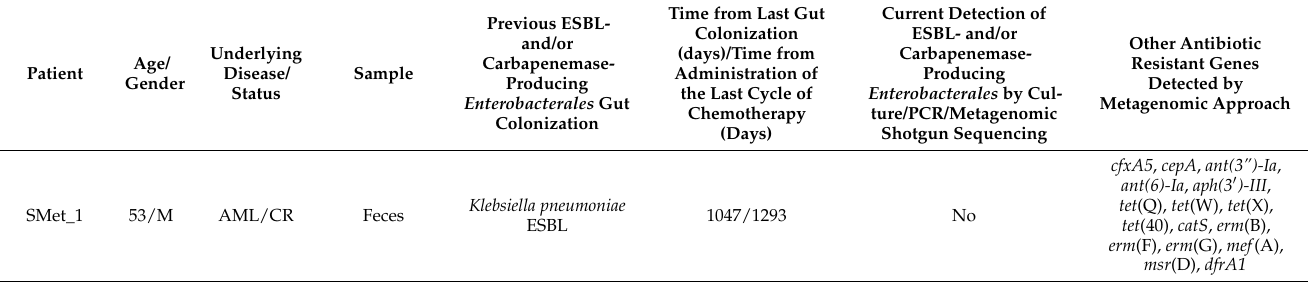
Table 1. Clinical and microbiological information of outpatients recovered from acute leukemia or that underwent stem cell transplantation and who had been colonized by ESBL- and/or carbapenemase- producing Enterobacterales